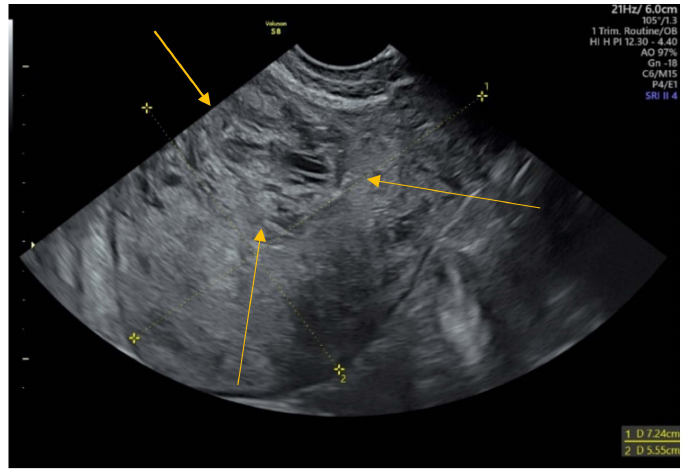
Figure 1. Abnormal echostructure of the uterus anterior